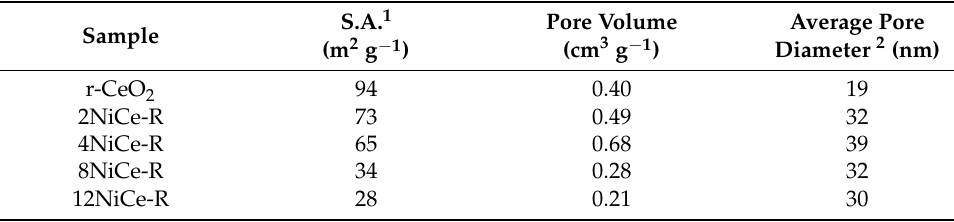
Table 5. Surface area and pore morphology of reduced samples.